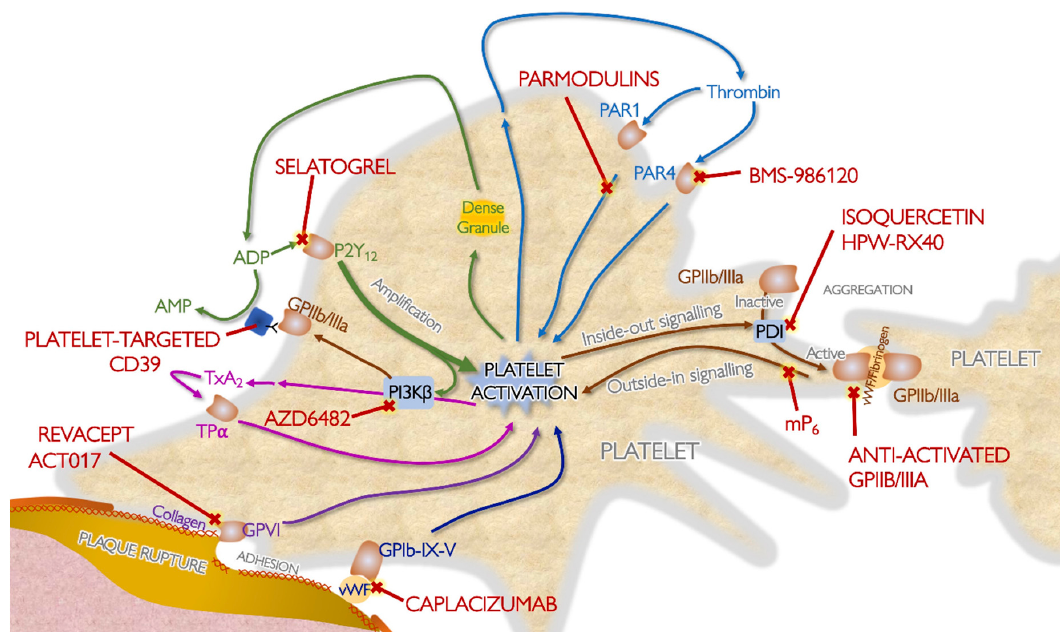
Figure 2. Examples of novel antiplatelet agents and their mechanisms of action. ADP, adenosine diphosphate; AMP, adenosine monophosphate; CD, cluster of differentiation; GP, glycoprotein; P2Y12, platelet ADP receptor; PAR, protease activated receptor; PDI, protein disulphide isomerase; PI3Kbeta, phosphoinositide 3-kinase; TPa, thromboxane receptor a; TxA2, thromboxane A2; vWF, von Willebrand factor.